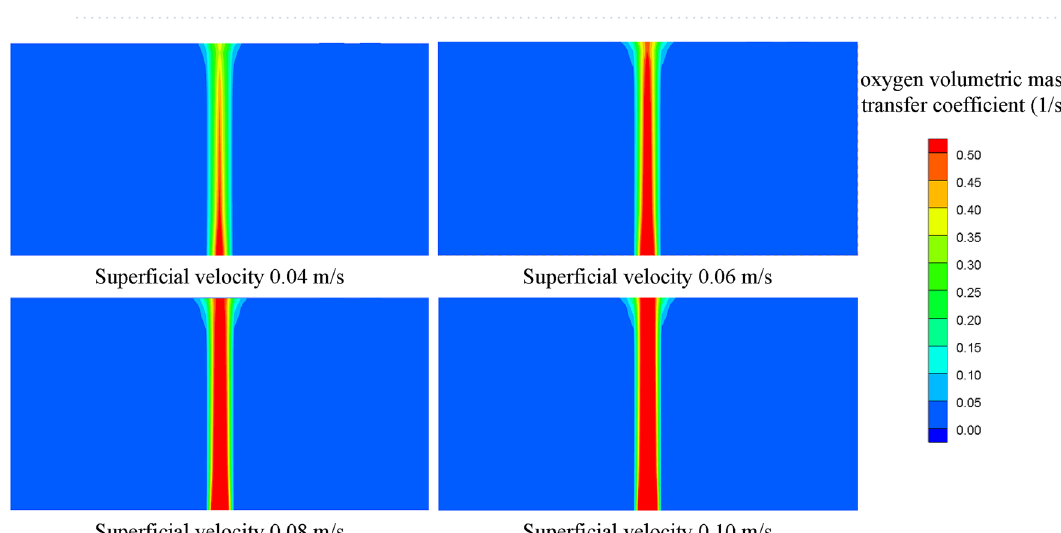
Figure 11. Oxygen volumetric mass transfer coefficients at different superficial